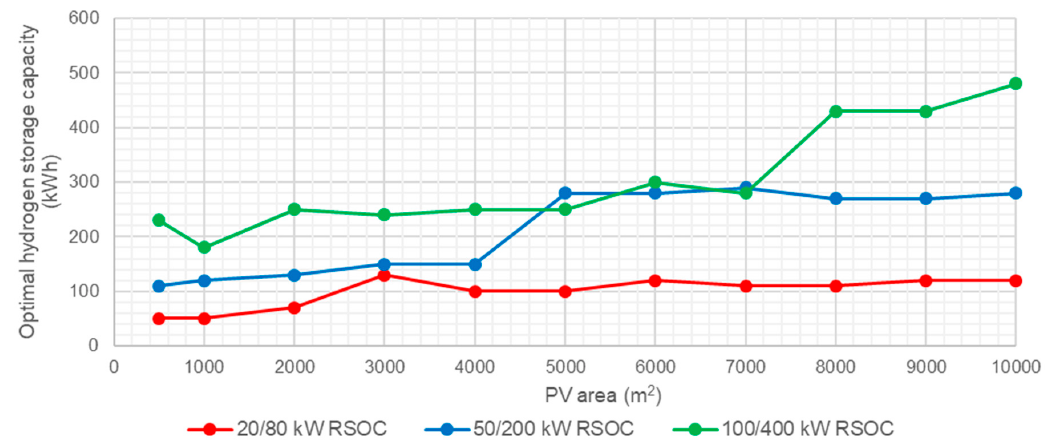
Figure 11. Optimal hydrogen storage size as a function of installed solar PV panel area for the three RSOCHS systems and the reference system.